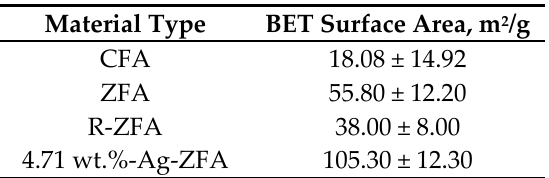
Table 1. BET surface areas of